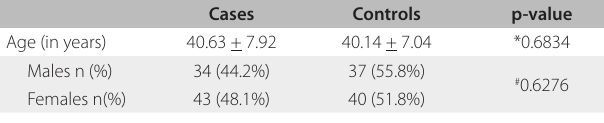
Table 3. Distribution of renal disease in case group Disease Frequency (%) Chronic kidney disease Diabetic kidney disease